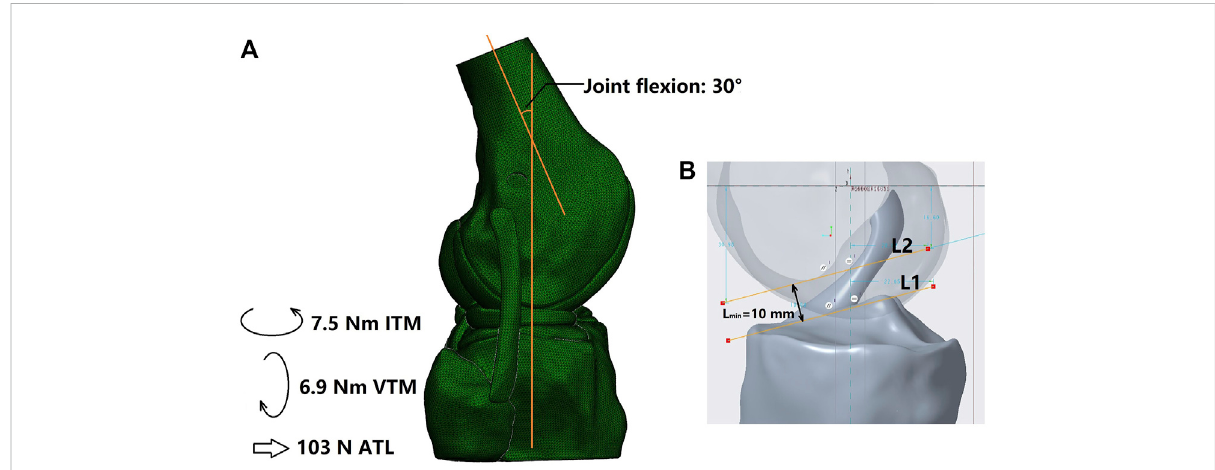
FIGURE 2 (A) Loading conditions and (B) Measurement of the minimum width of the space between the femoral notch and tibial plateau (L min ). L1 was plotted as a line tangent to the tibial plateau and parallel to L2 and L2 was tangent to the top contour of the femoral notch. ITM, internal tibial moment; VTM, valgus tibial moment; ATL, anterior tibial